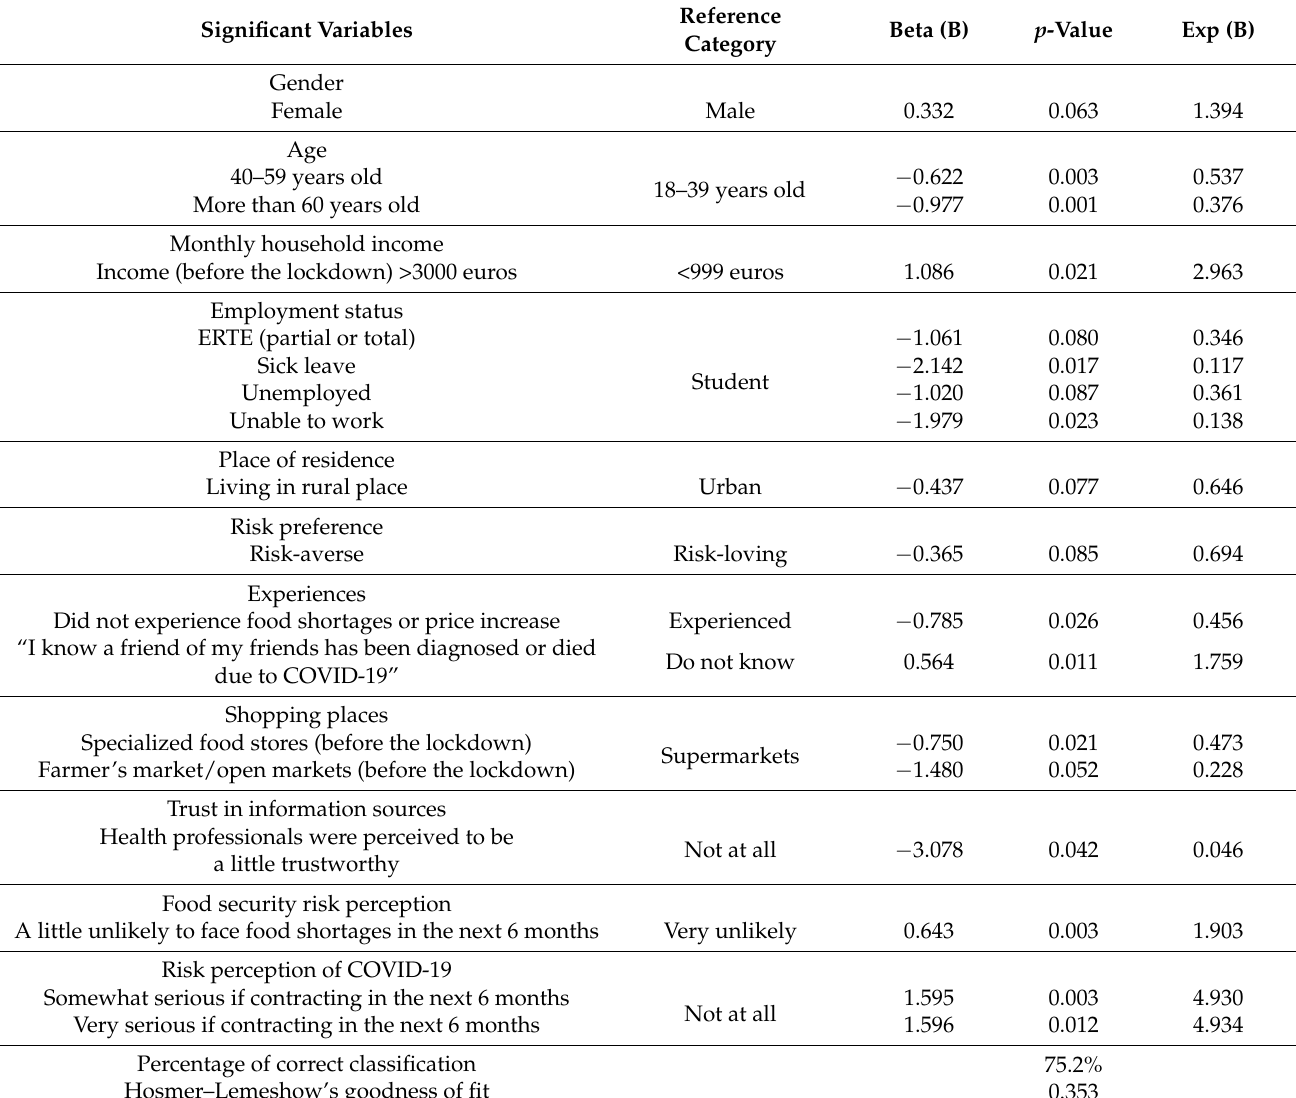
Table 4. Logit model of total food consumption (C)